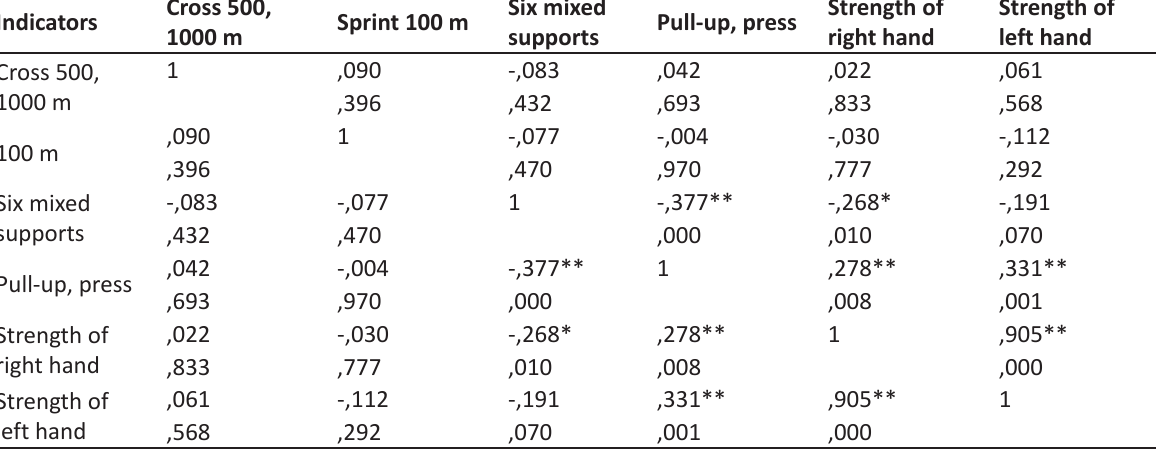
Table 5. Pearson correlations. Morphofunctional indicators